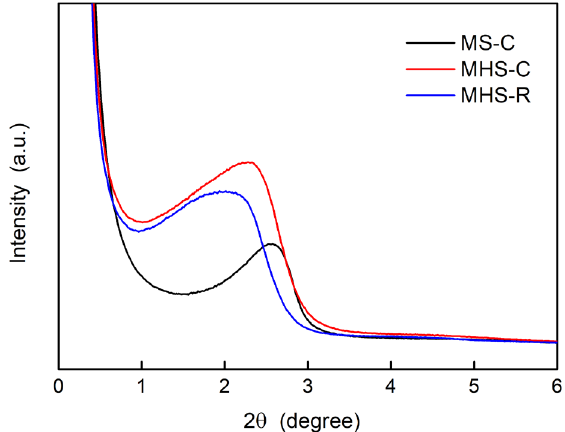
Figure 3. Low angle XRD patterns of mesoporous silica and mesoporous hollow silica nanomateri- als.